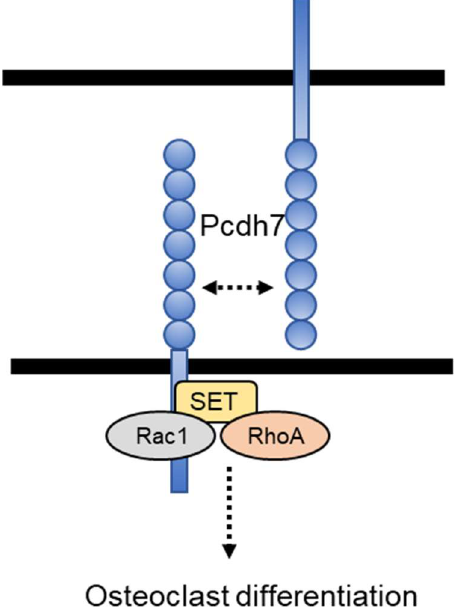
Figure 5. Schematic model of regulation of osteoclast differentiation by Pcdh7. Pcdh7 interacted with SET and small GTPases RhoA and Rac1 through the SET-binding domain. Ligation of Pcdh7, which might be mediated in a homophilic manner, activates intracellular signaling including RhoA and Rac1 activation and, consequently, induces osteoclast multinucleation and differentiation. Dashed two-way arrow indicates assumption. Dashed arrow presumes involvement of a number of signaling molecules.